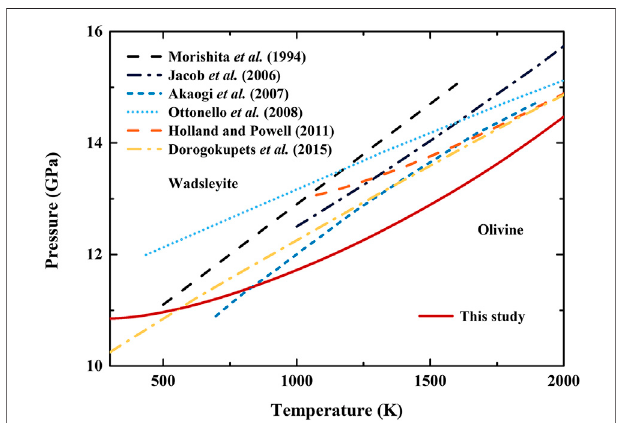
FIGURE 7 | Summaries of the variations of X Fe during the olivine- wadsleyite phase transition in (Mg,Fe) 2 SiO 4 system. Ol refers to olivine, and Wds refers to wadsleyite. Red solid line: this study; Green stars: Katsura and Ito (1989); Orange circles: Chen et al. (2002); Blue diamonds: Katsura et al.